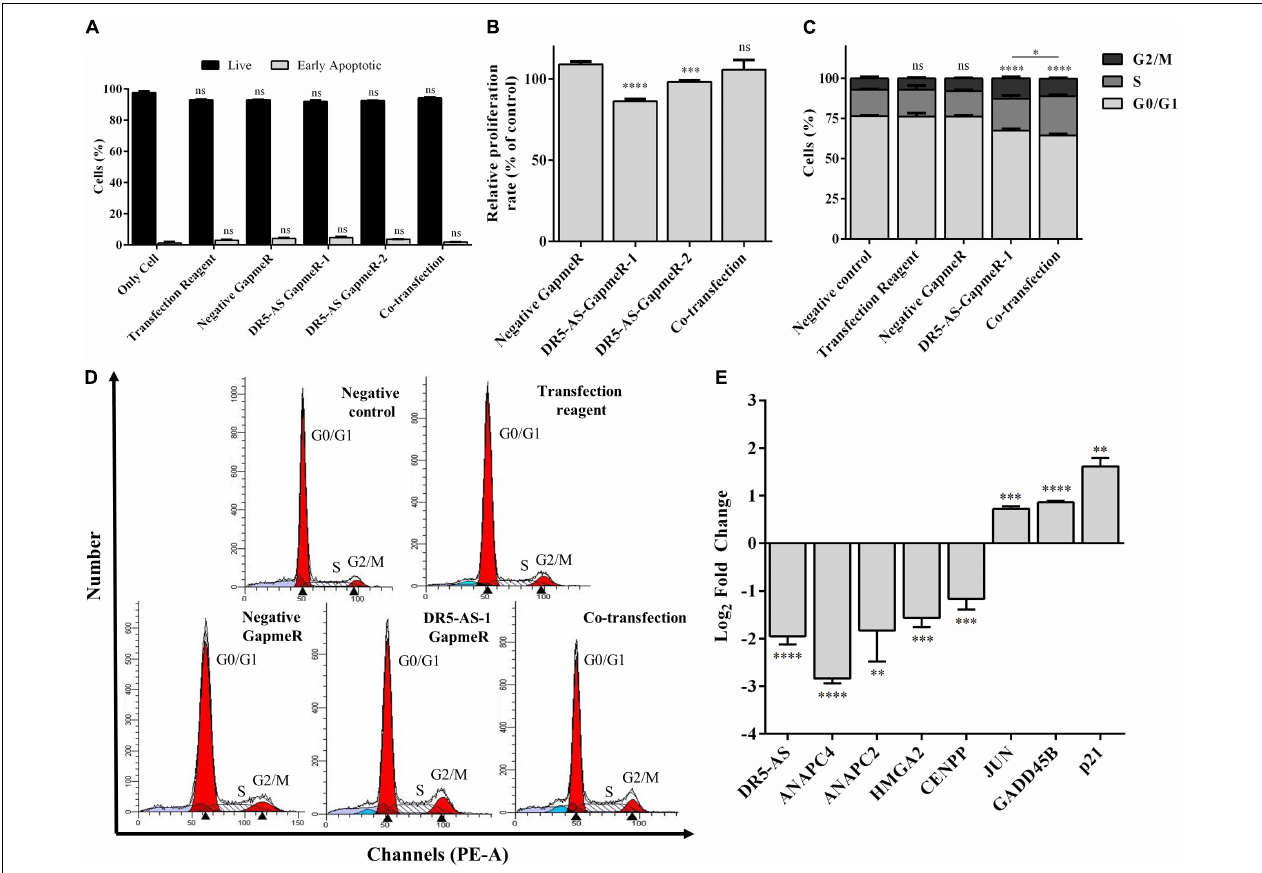
FIGURE 6 | DR5-AS knockdown modulates proliferation and cell cycle in HeLa cells. (A) The rate of early apoptosis in HeLa cells under various transfection conditions was determined by flow cytometry. HeLa cells were transfected with DR5-AS GapmeR alone (DR5-AS GapmeR-1 and DR5-AS GapmeR-2) or in combination of DR5-AS GapmeR-1 with pcDNA3.1-DR5-AS (co-transfection). Only cell (no transfection), transfection reagent (no GapmeR or plasmid) and negative GapmeR were used as controls. 72 h post-transfection, the rate of early apoptotic cells was determined by Annexin V/7AAD staining. The stained cells were analyzed by a flow cytometer. (B) Proliferation rate of HeLa cells transfected with DR5-AS GapmeR alone (DR5-AS GapmeR-1 and DR5-AS GapmeR-2) or in combination of DR5-AS GapmeR-1 with pcDNA3.1-DR5-AS (cotransfection) for 72 h. Untransfected (Negative control) and transfected (Transfection Reagent, Negative GapmeR, DR5-AS-GapmeR-1 or co-transfection) HeLa cells described in Figure 4C were also subjected to cell cycle analysis and the percent of cells in each phase (C) was calculated from DNA histograms (D) . (E) qPCR analyses of genes associated with cell cycle in DR5-AS knockdown HeLa cells (Negative GapmeR versus DR5-AS-GapmeR-1). ns, non-significant ( p > 0.05), * p ≤ 0.05, ** p ≤ 0.01, *** p ≤ 0.001, **** p ≤